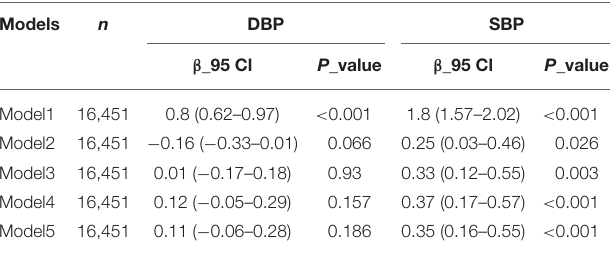
Model1: not adjusted. Model2: adjusted for age, gender, and race. Model3: model2 + Marital status, BMI, PIR, and education level. Model4: model3 + DM, Hypertension, smoking status, work activity, alcohol consumption, and CVD. Model5: model4 + albumin/urine.